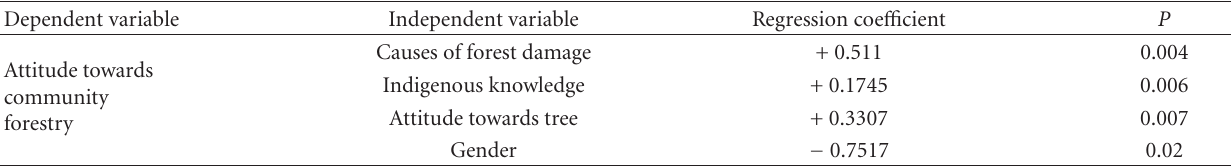
Table 1: E ff ect of some selected variables on respondents’ attitude towards community forestry.